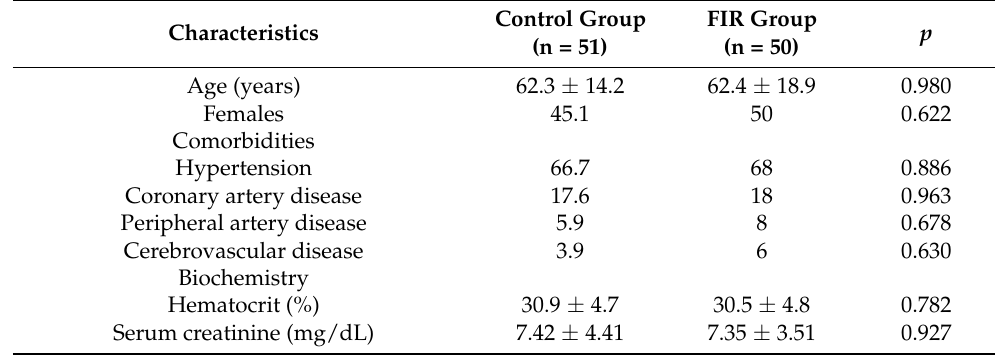
Figure 1. Study enrollment flow chart of participants in the randomized controlled trial to evaluate the effect of FIR therapy on AVF Qa and plasma ADMA concentrations in advanced DKD patients. Abbreviations: FIR, far-infrared; HD, hemodialysis; AVF, arteriovenous fistula; Qa, access blood flow; ADMA, asymmetric dimethylarginine; DKD, diabetic kidney disease. Table 1. Comparison of baseline clinical characteristics between advanced DKD patients with and without FIR therapy for 12 months.